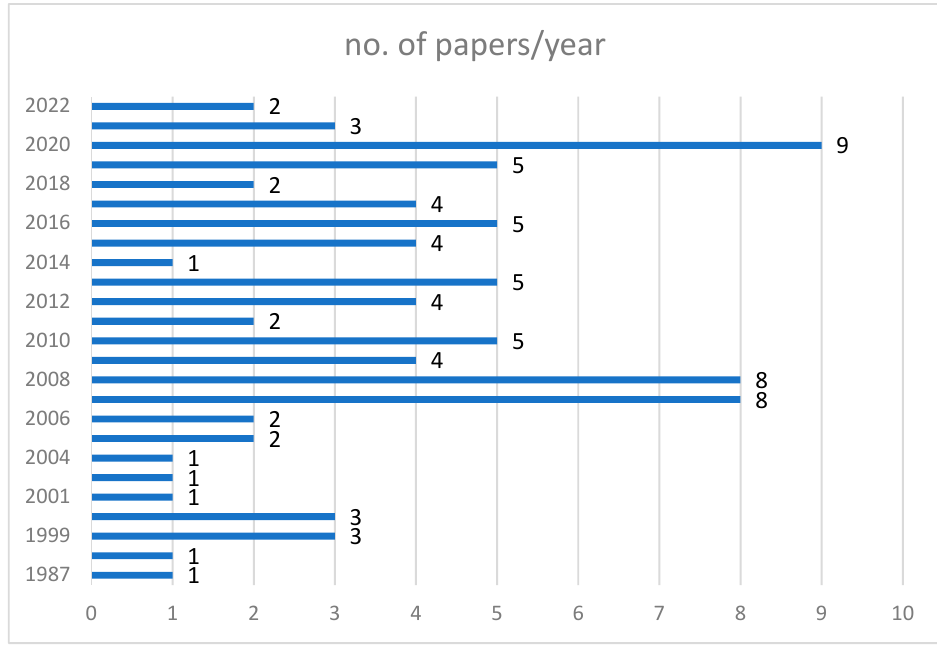
Figure 3. No. of published works per year.